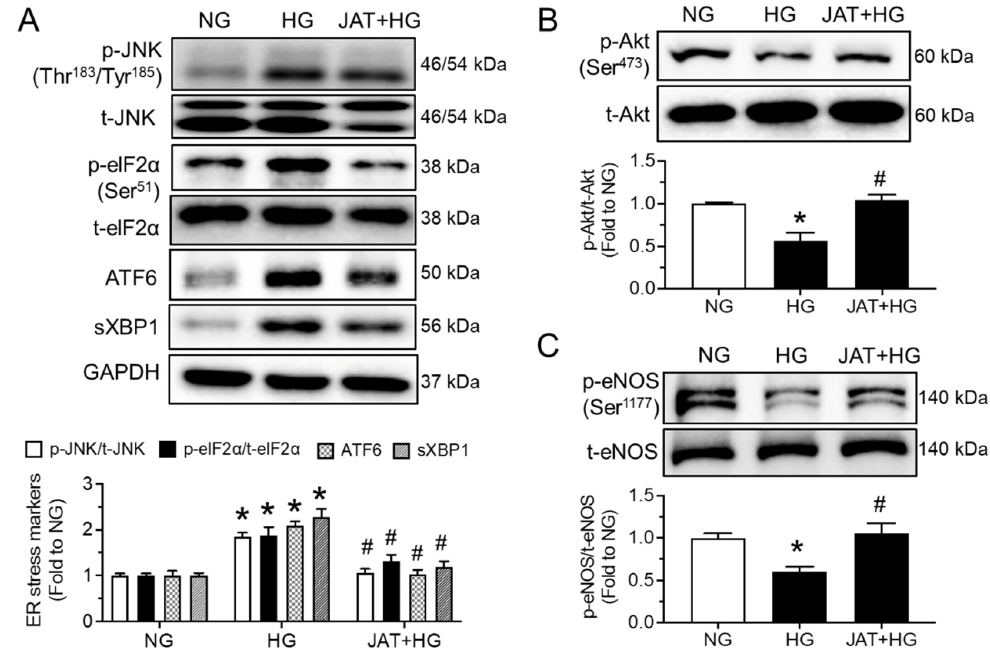
Figure 4. Effect of jatrorrhizine on endoplasmic reticulum stress and Akt/eNOS pathway in aortas from DIO mice ex vivo. ( A – C ) Western blotting of ER stress markers, phosphorylation and total Akt and eNOS in aortas from DIO mice induced by high-fat diet (45% kcal% fat) plus single intraperitoneal injection of streptozotocin (120 mg/kg) and treated with JAT (1 µ M) for 24 h ex vivo. Results are mean ± SEM of 5–6 experiments. * p < 0.05 vs. DIO.